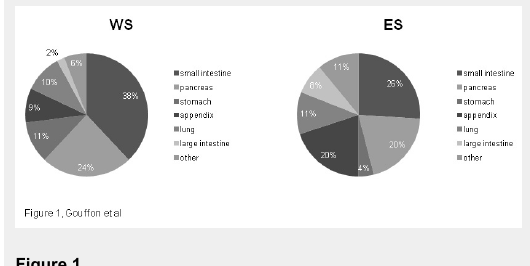
Repartition of primary tumours by organ in WS and ES. WS = Western Switzerland; ES = Eastern